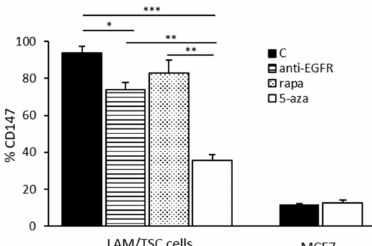
Figure 6. Effect of anti-EGFR antibody, rapamycin, and 5-azacytidine on CD147 expression. The percentage of LAM/TSC cells positive to CD147 was evaluated by flow cytometry after incubation for 48 h with anti-EGFR antibody and rapamycin for 48 h. The percentage of CD147 positivity was analyzed in control LAM/TSC cells and MCF7 cells, and after exposure to 5-azacytidine for 96 h. ANOVA with Tukey test ± SEM ( n = 3 experiments) * p < 0.05; ** p < 0.01; *** p < 0.001. MCF7 c vs. MCF7 aza were analyzed by Student t -test.